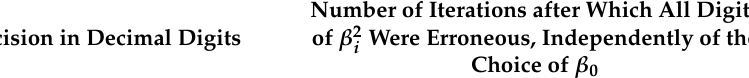
Table 9. Table demonstrating the number of iterations after which the output of the algorithm described in Case 1 of the present Section, offered totally erroneous results, for various employed finite word lengths n . The results are in full accordance with the theoretical analysis presented in the previous sub-sections. The experimentally observed results are in excellent agreement with the content of Theorem 1 of Section